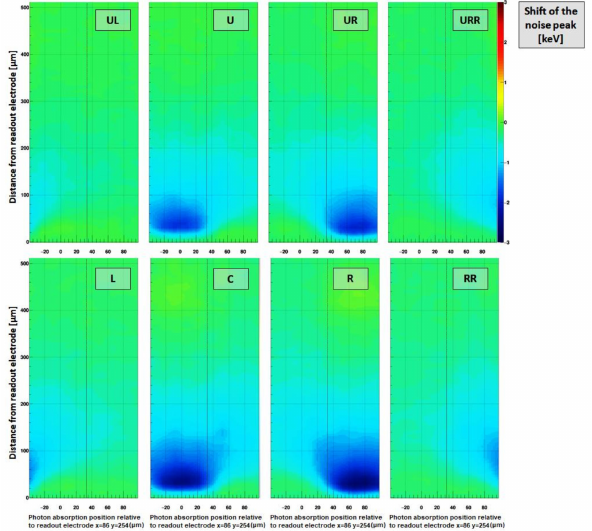
Figure 17. Shift of the pedestal in frames without photons. The irradiated pixels are pixel C (x = 86 y = 254) and pixel R (x = 87 y = 254). The energy position of the pedestal of the eight previously observed pixels is plotted as function of the interaction point in the irradiated pixels. Only frames without photon hits were used for this analysis. The pedestal shift is present, when photons are absorbed in the half of the sensor closer to the readout electrode and it can reach values down to − 2 keV. No relaxation effect could be observed, i.e., this pedestal shift has some temporal persistence which has not been further